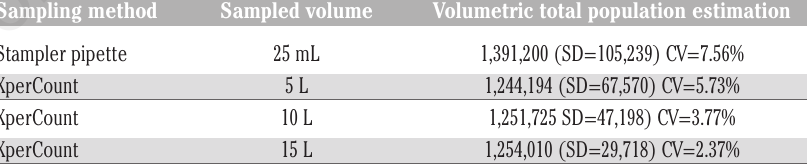
Table 2. Results for estimating a shrimp larvae population using different volume sub- samples.